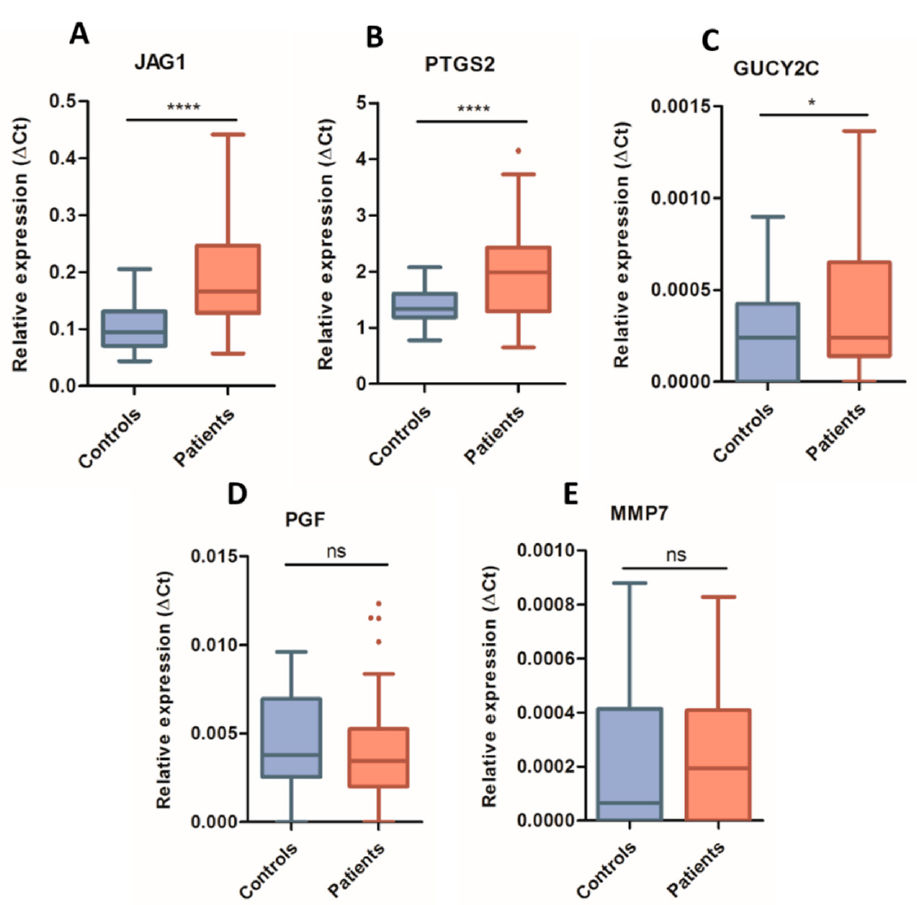
Figure 1. Relative quantification of gene expression levels by digital PCR in whole blood samples. Expression levels of JAG1 ( A ), PTGS2 ( B ), GUCY2C ( C ), PGF ( D ) and MMP7 ( E ) genes were deter- mined in whole blood samples from metastatic colon cancer patients (red) and healthy controls (blue), normalized by MTR expression and calculated by the ∆ Ct method. In box plots, boxes show the interquartile range (IQR), whiskers indicate Q1-1.5xIQR and Q3 + 1.5xIQR values, inner lines indicate medians. (*) p < 0.05; (****) p < 0.0001; (ns) not significant. Next, we selected the most upregulated genes ( JAG1 , PTGS2 and GUCY2C ) in the blood cells of CRC patients to determine the presence of circulating mRNA in the matched serum samples. As shown in Figure 2, the three modulated genes showed a clear and statistically significant ( p < 0.0001) upregulation in serum from these patients (Figure 2A–C) relative to controls. Furthermore, although PGF was not significantly increased in blood cells from CRC patients, it was also analyzed because of its role promoting angiogenesis, in resistance to antiangiogenic therapy and as an alternative pro-angiogenic ligand to VEGF-A in the VEGF pathway. PGF showed a clear upregulation ( p < 0.01) in our cohort of patients (Figure